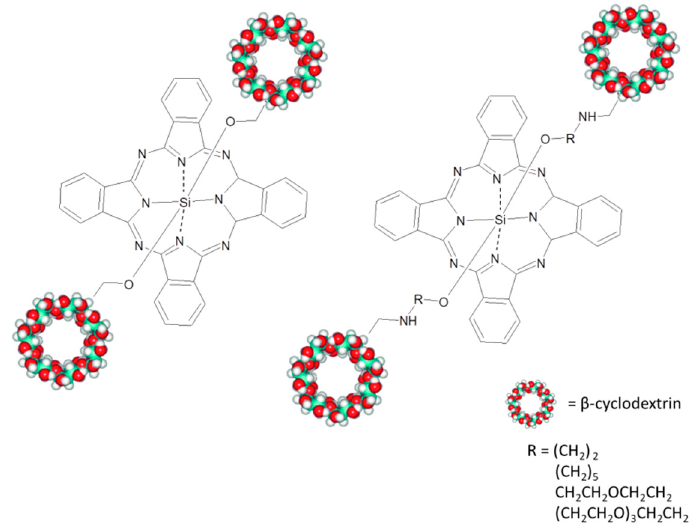
Figure 17. Silicon(IV) phthalocyanines axially substituted with permethylated β -cyclodextrin used in [104].